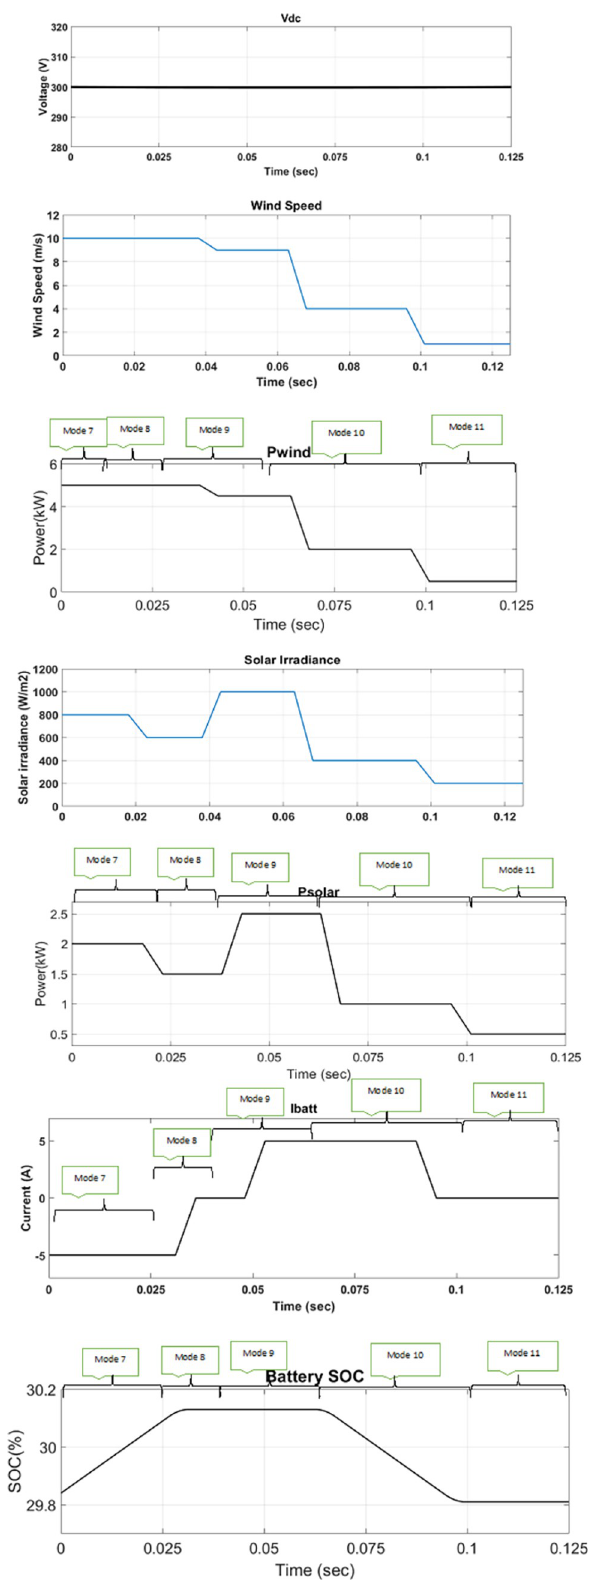
Fig 19. Standalone mode under variable DRES generation and